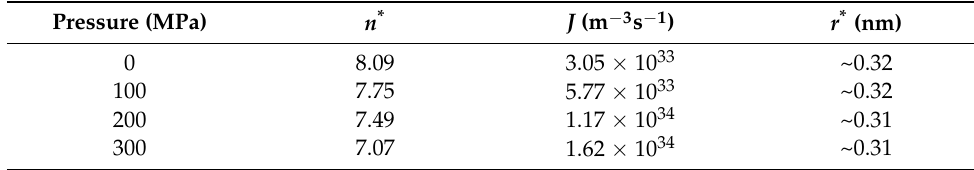
Table 1. Critical size n ∗ , nucleation rate J and critical nucleus radius r ∗ during the isothermal- solidification processes under different pressures.